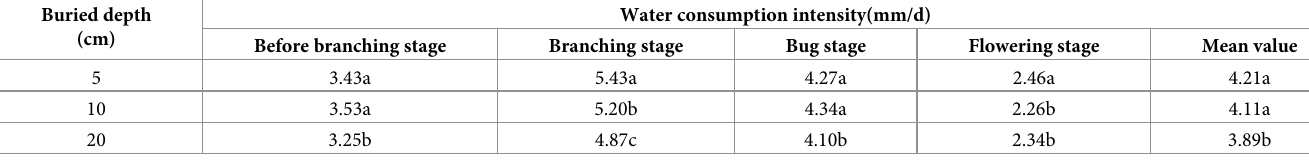
Table 3. Water consumption intensity under different treatments during one fertility period. Buried depth